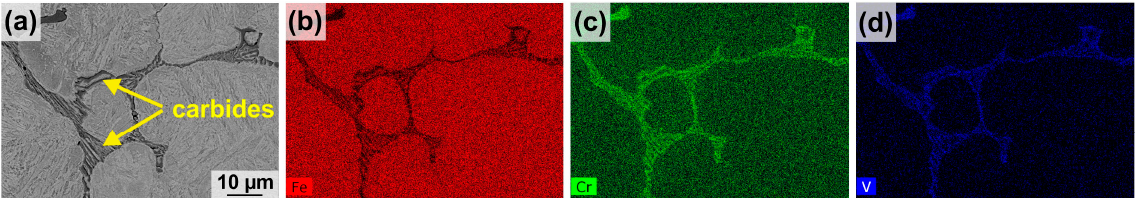
Figure 3. Microstructural analyses by ( a ) a SEM image (SE contrast) with associated EDS-maps of elemental distributions of ( b ) iron, ( c ) chromium and ( d ) vanadium.